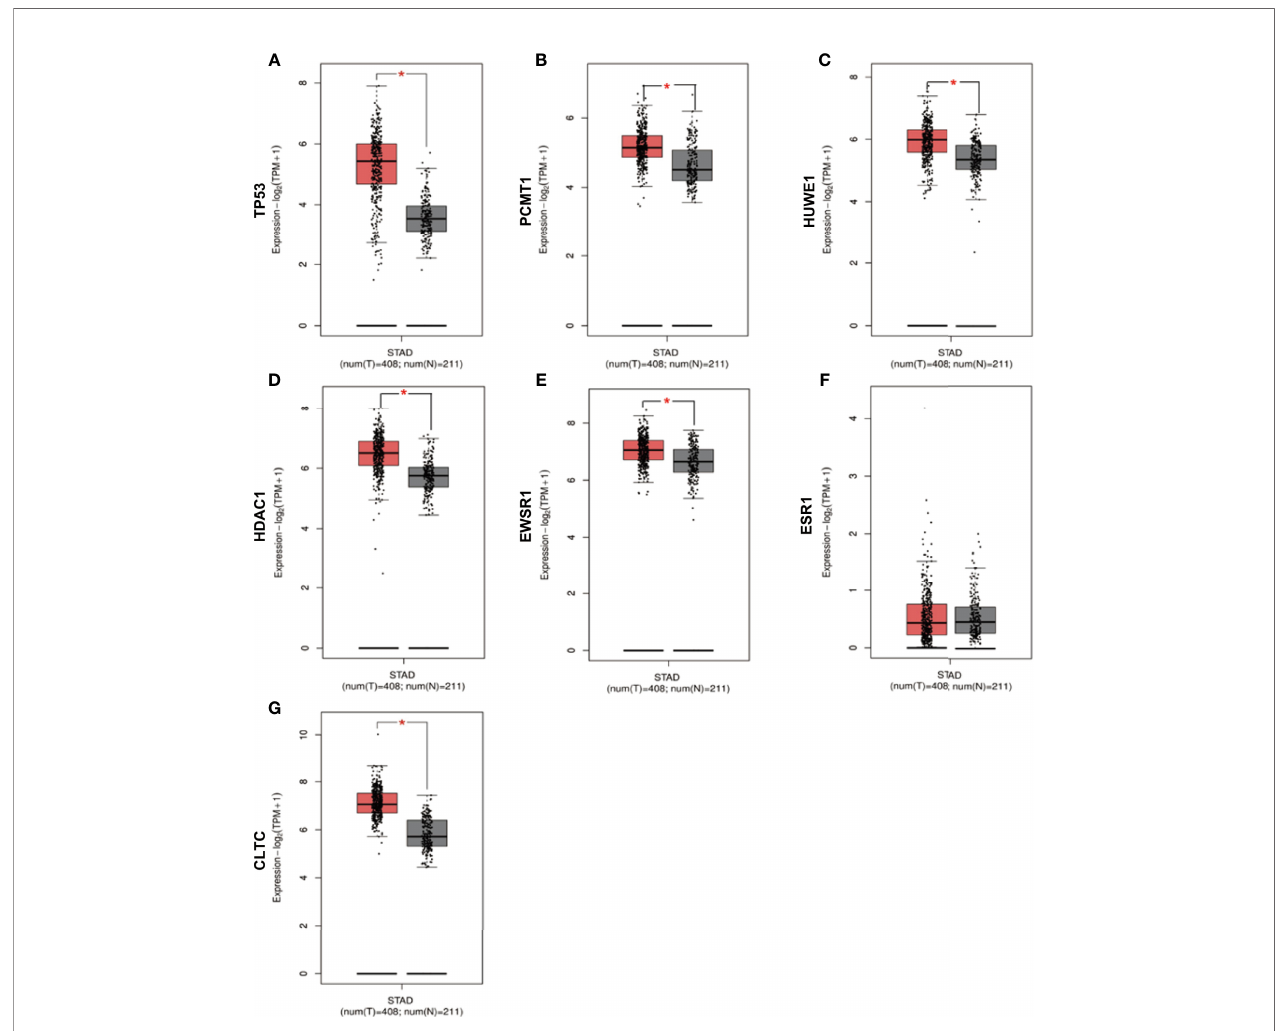
FIGURE 7 | Veri fi cation of the expression level of 7 hub genes in STAD and normal tissues from GEPIA2 database. (A) Gene expression valueTP53 among samples of TCGA. (B) Gene expression value PCMT1 among samples of TCGA. (C) Gene expression value HUWE1 among samples of TCGA. (D) Gene expression value HDAC1 among samples of TCGA. (E) Gene expression value EWSR1among samples of TCGA. (F) Gene expression value ESR1 among samples of TCGA. (G) Gene expression value CLTC among samples of TCGA. Data are expressed in mean ± SEM; *P < 0.05, normal group versus tumor